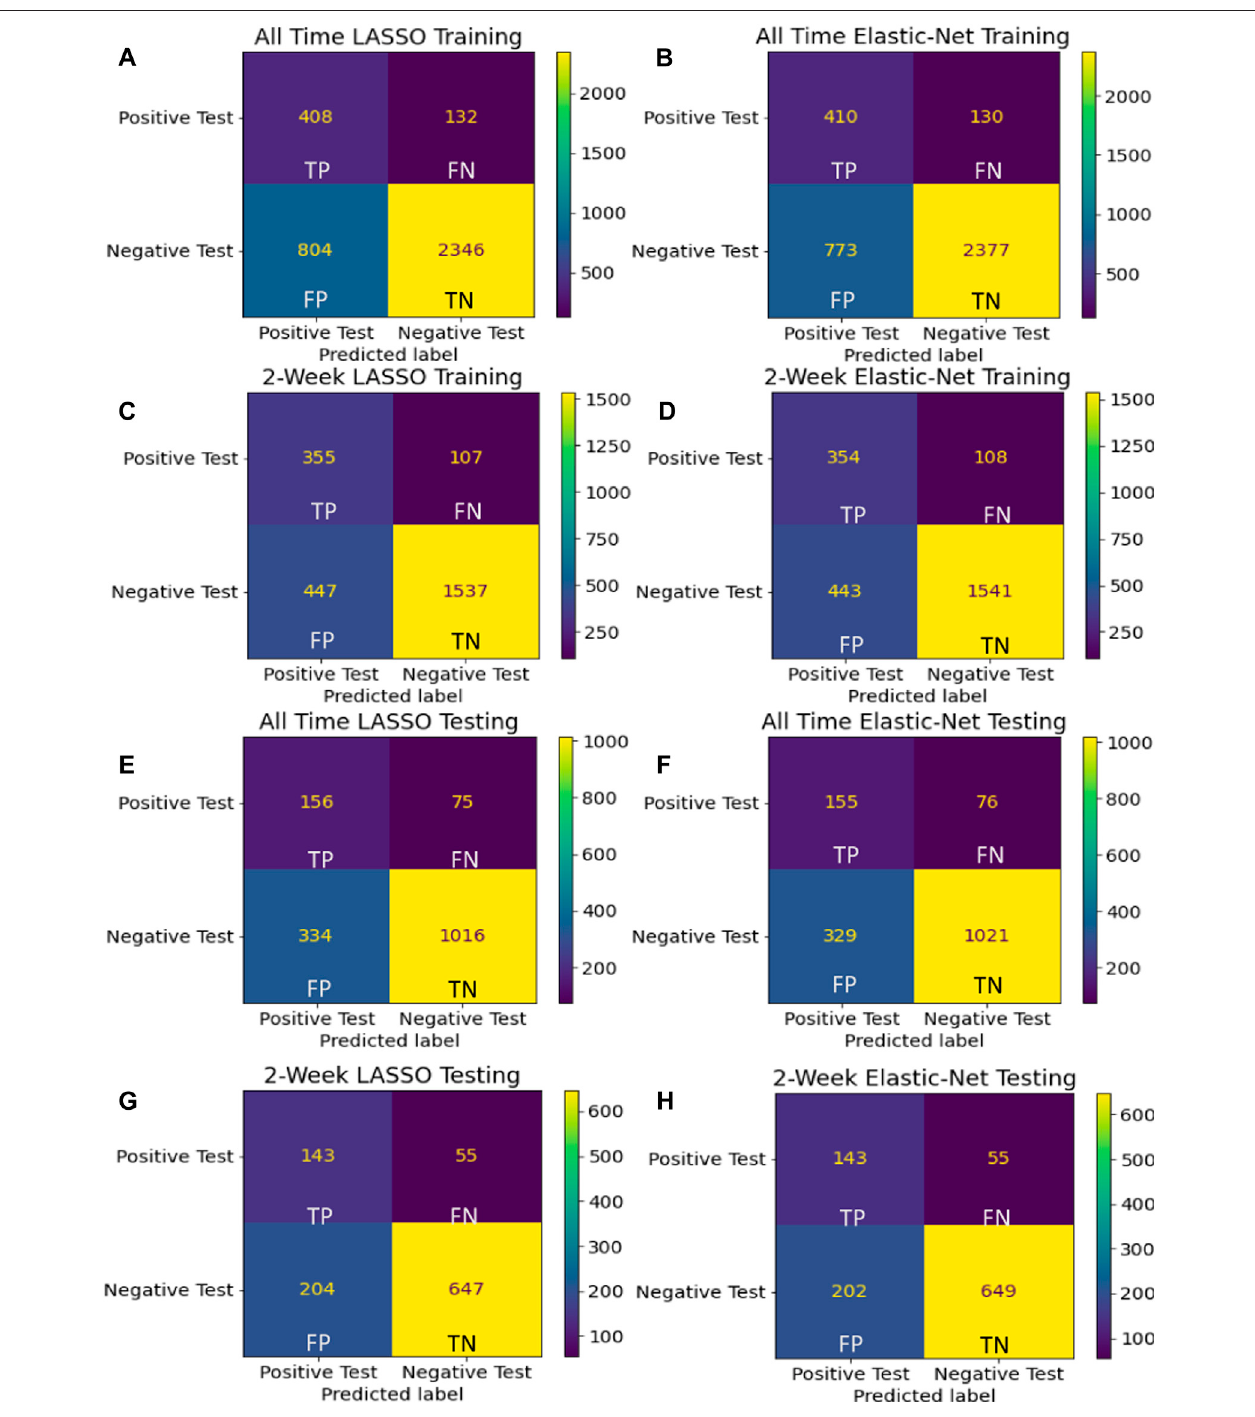
FIGURE 3 | Confusion matrices Confusion matrices using training (A – D) and holdout (E – H) data are shown for the fi nal model for each of the four assessed techniques. Considering that these models are built to recommend COVID-19 testing, we sought to avoid False Negative predictions while being more lenient towards False Positive